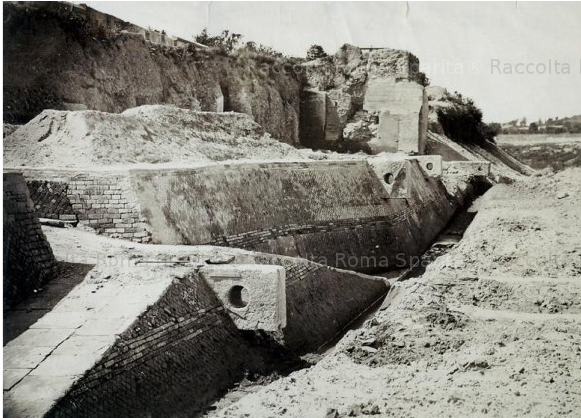
Figure 3. Historical photo taken during the construction of